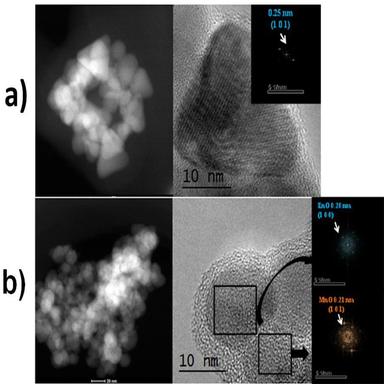
a) HR-TEM micrograph selected of ZnO nanoparticles, b) HR-TEM micrograph selected of ZnO/MnO(Mn=5.0%) nanocomposite.